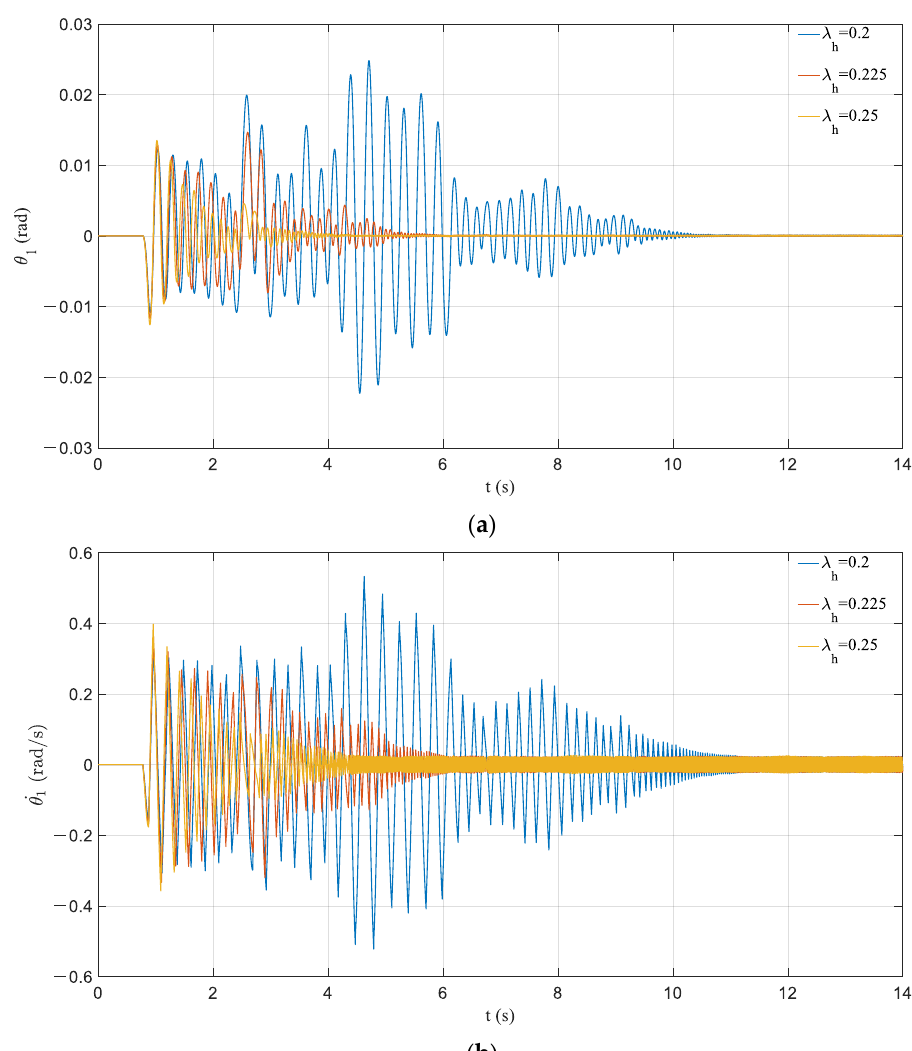
Figure 16. Effect of variation in λ h : ( a ) time history of rocking rotation; ( b ) time history of angular velocity.